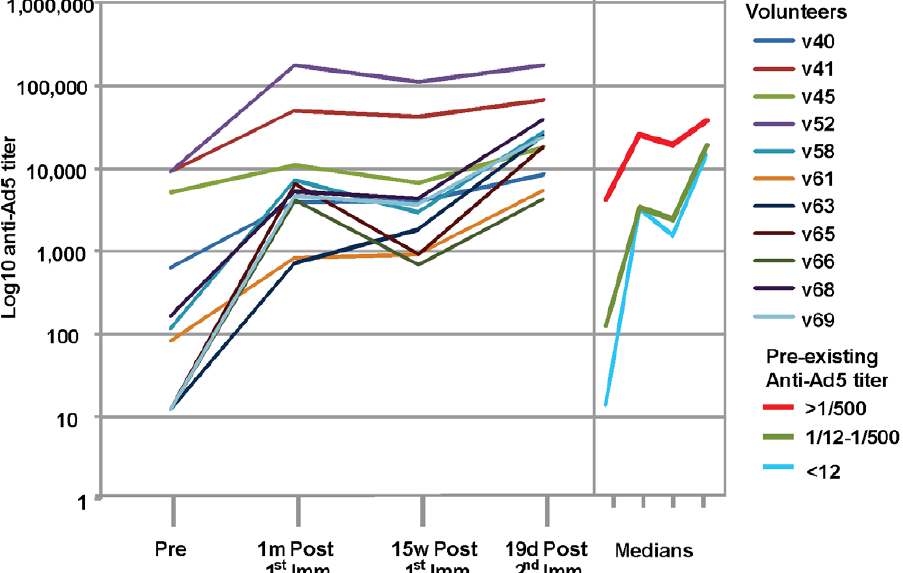
Figure 10. Anti-Ad5 NAb titers. Anti-Ad5 neutralization titers were measured pre-immunization (Pre) and 1 month and 15 weeks post 1 st immunization and 19 days post 2 nd immunization. Volunteers are shown in color-coded lines. Right Panel: median NAb titers of volunteers with high ( . 500), low (12–500) or absent ( , 12) titers at the time of enrolment.